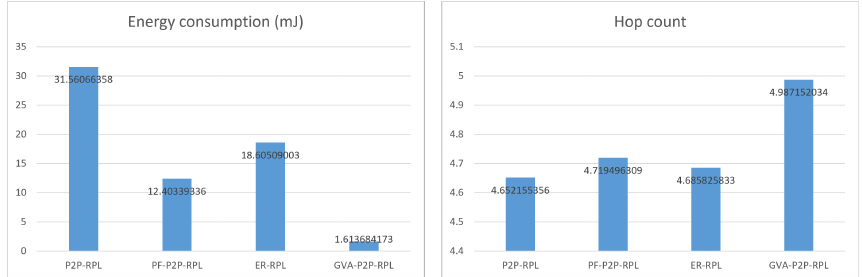
Figure 22. Energy consumption (mJ) and hop count.